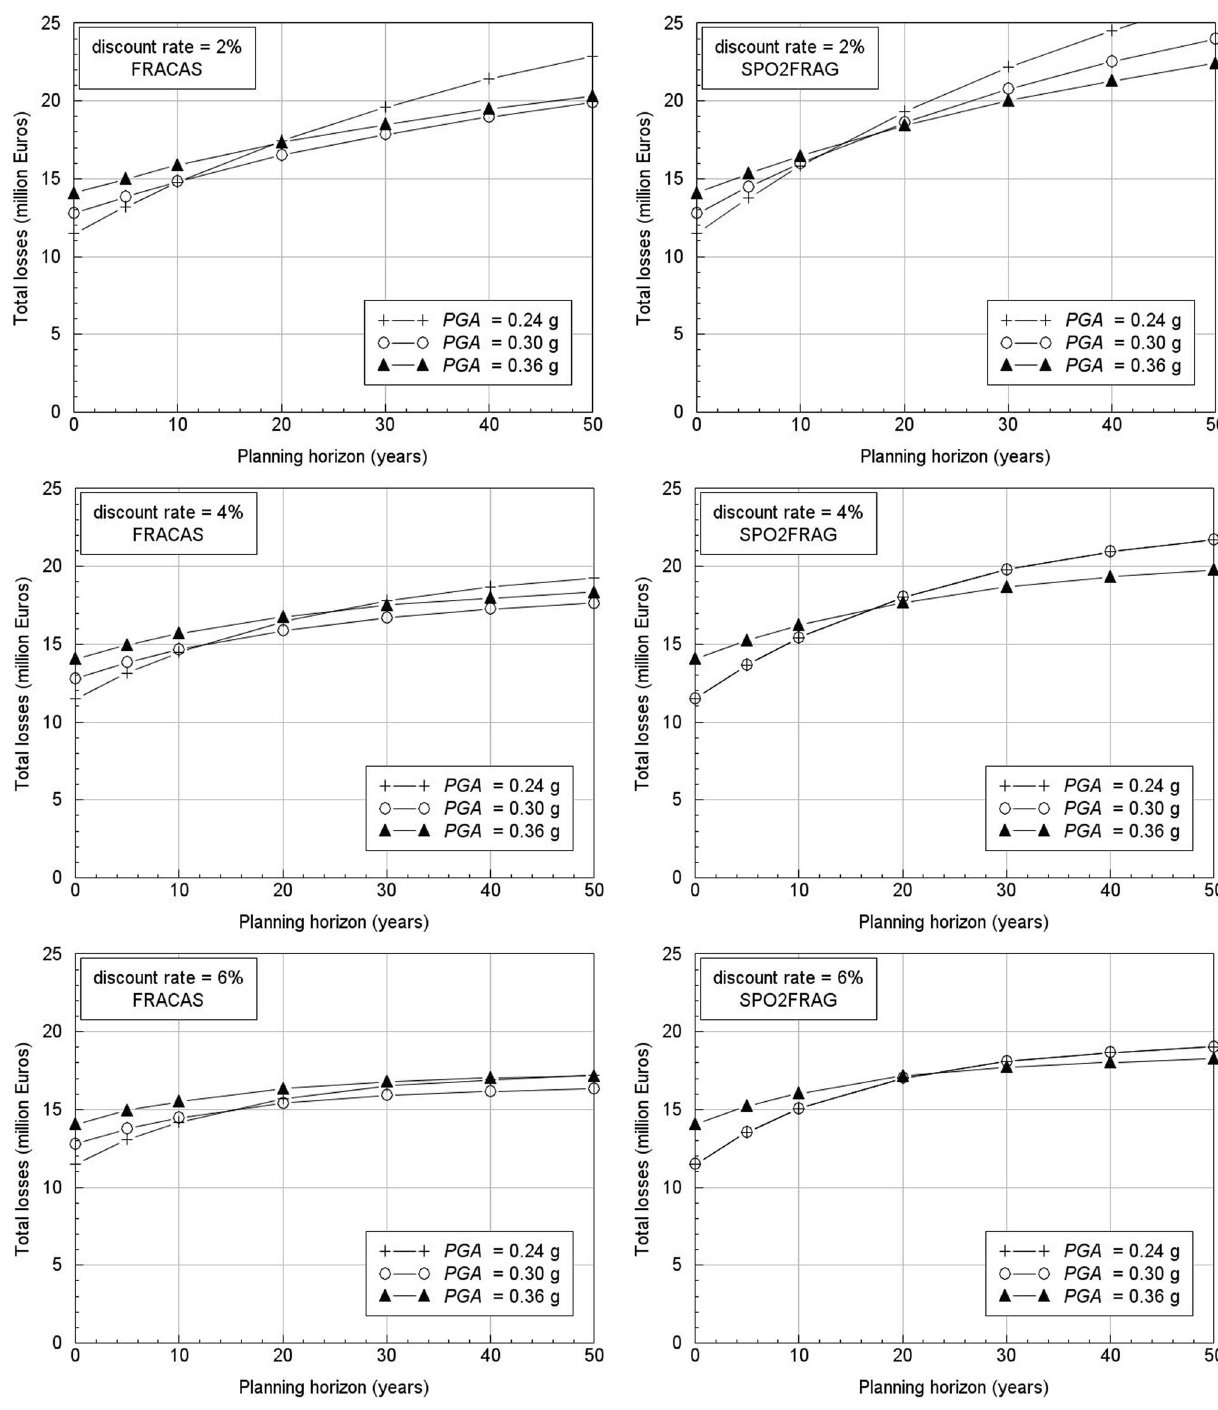
Fig. 11 The results of the life-cycle analysis of structures in Bucharest, Romania, as a function of the discount rate. The results were obtained taken into account the damage degree computed using the FRACAS and SPO2FRAG methodologies. PGA peak ground